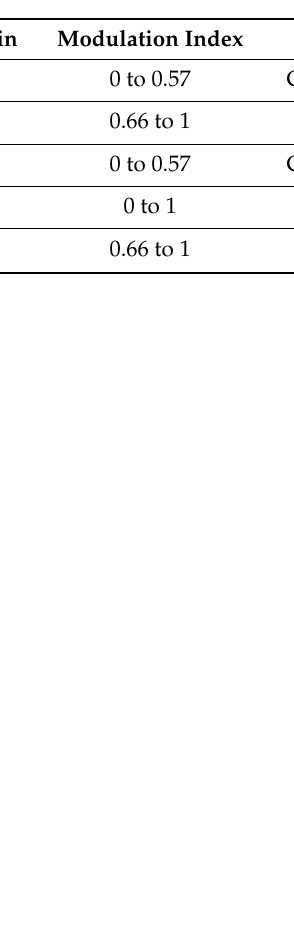
Table 3. Comparison between the MAqZSI with other CMV reduction Z-source inverters.